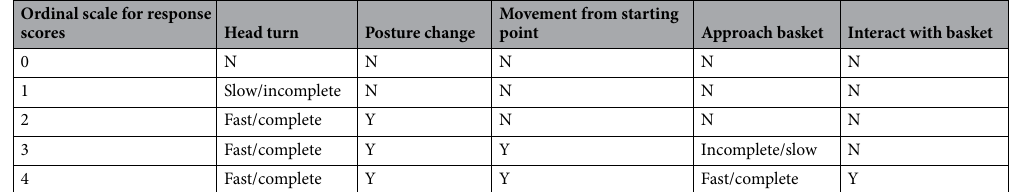
Table 2. Definitions for ordinal scale of attentional responses to the stimuli where 0 is no visible reaction and 4 is strongest